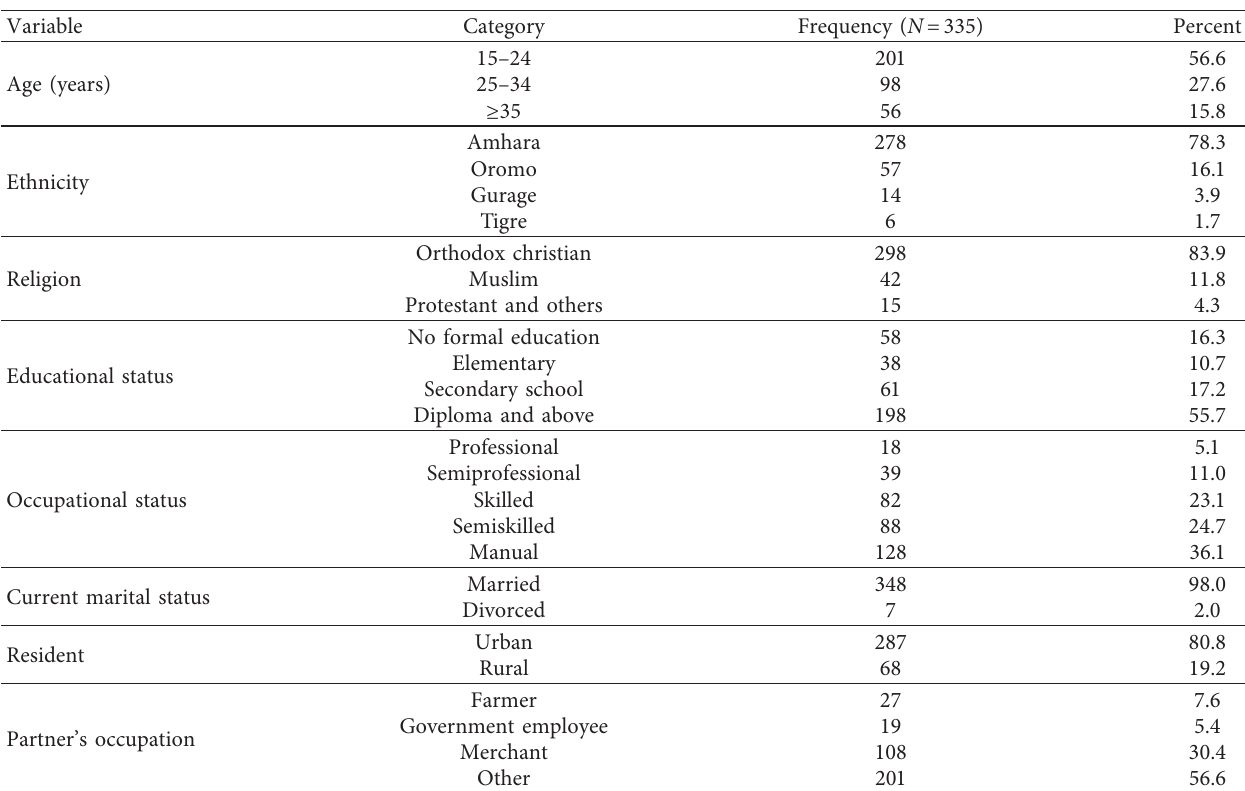
Table 1: Sociodemographic characteristics of pregnant women attending ANC at public health facilities, Debre Berhan Town, June 2019 ( N � 355).